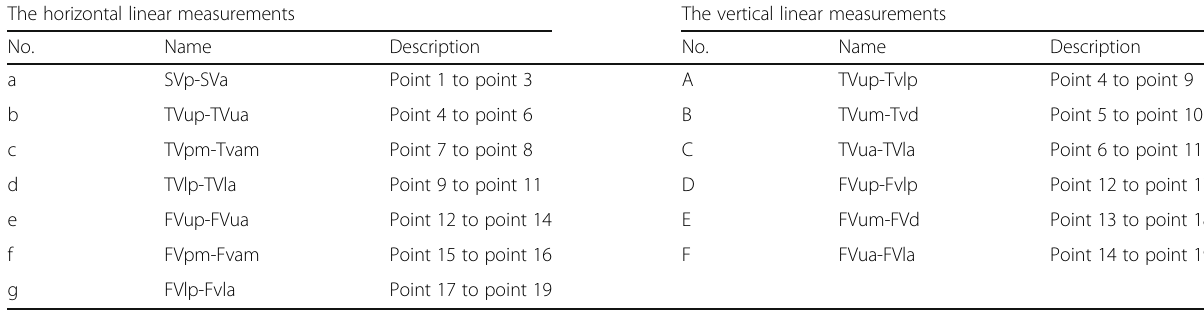
Table 2 The horizontal and vertical linear measurements The horizontal linear measurements The vertical linear measurements